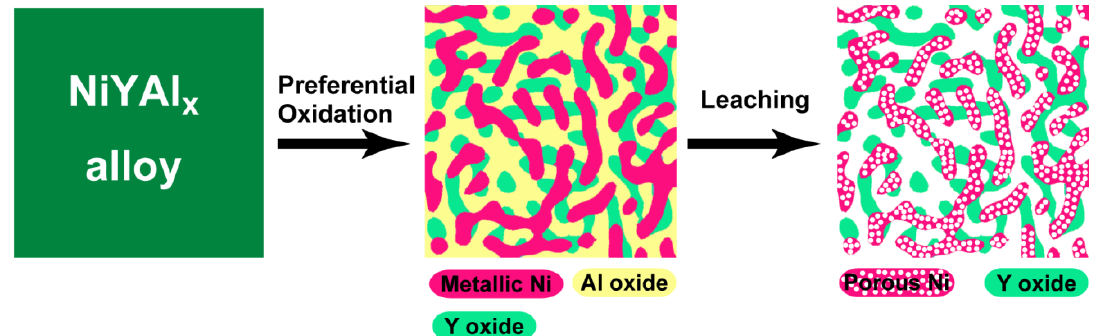
Figure 1. Schematic illustration of the catalyst preparation from NiYAl x alloys.